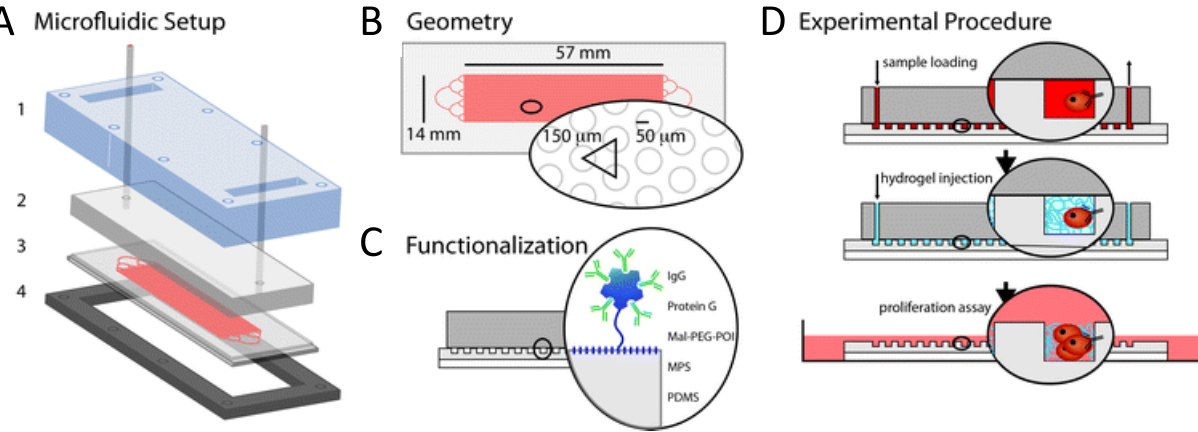
Figure 3. Proposed microfluidic setup by Bichsel et al . [97] that allows cancer cells to